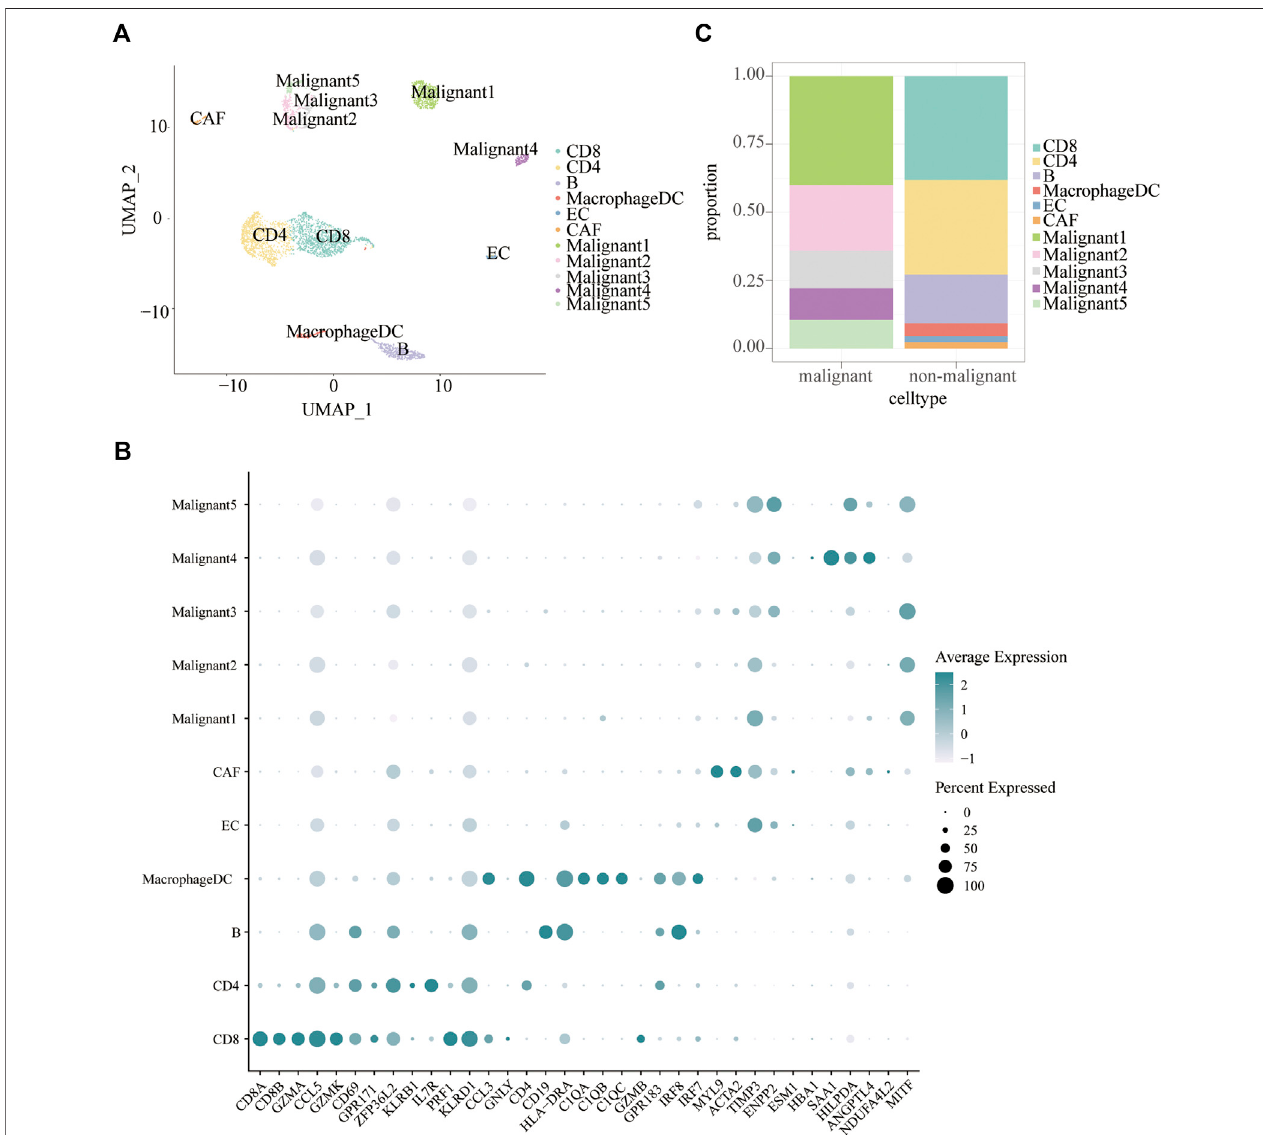
FIGURE 2 | Cell subpopulations in melanoma. (A) Uniform manifold approximation and project (UMAP) visualization of transcriptional pro fi les of melanoma. Each dotrepresentsasinglecell,andeachcolorrepresentsacelltype. (B) Barplotsshowingtheproportionofeachcelltypeinmalignantandnon-malignantcells. (C) Dotplot displaying known markers for each cell